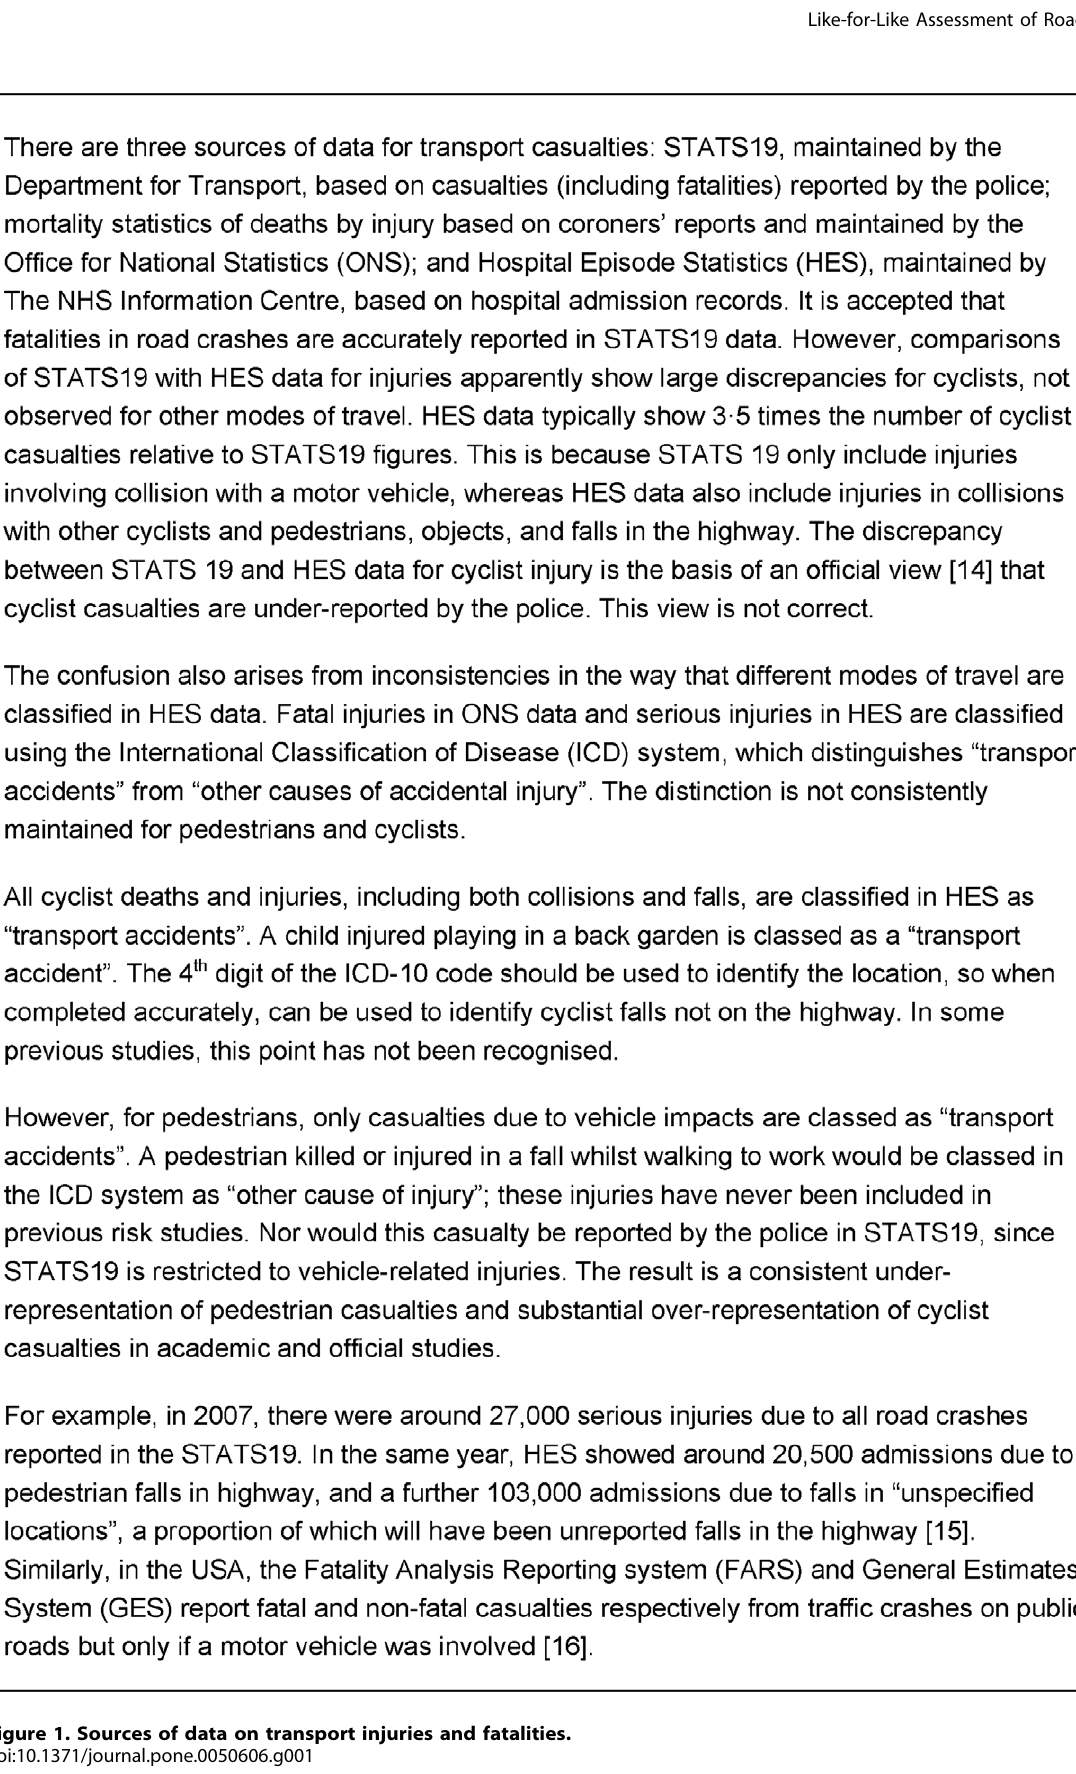
PLOS ONE | www.plosone.org